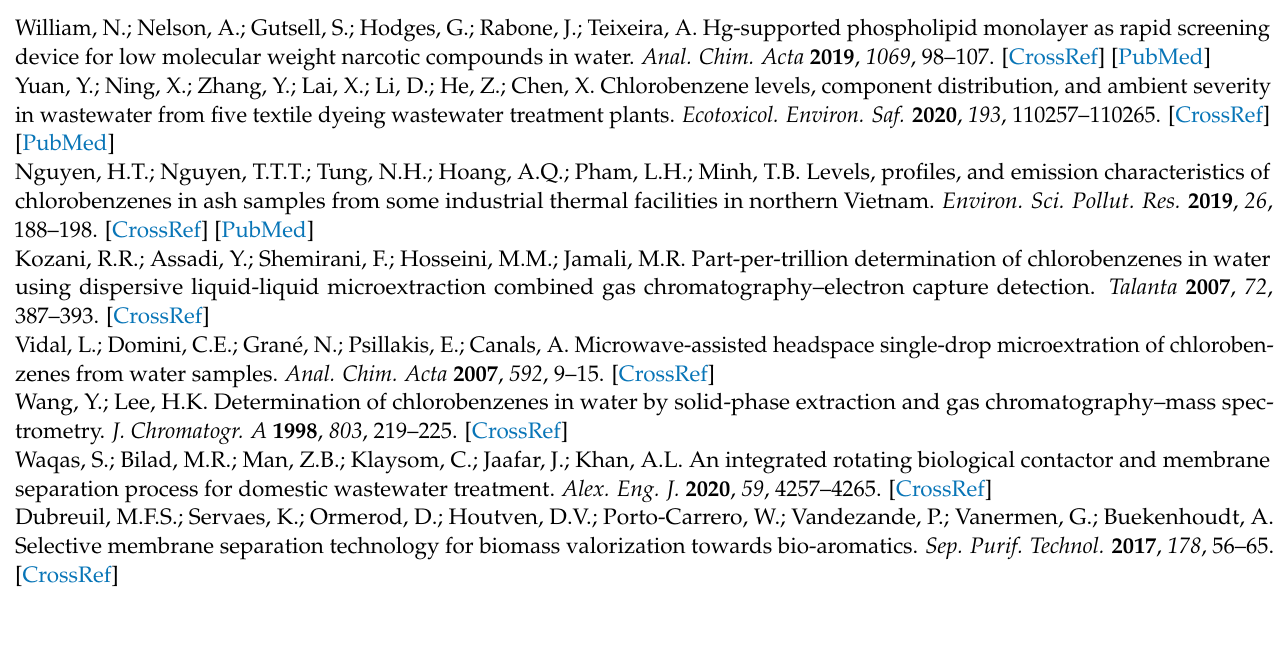
Figure S6: Effect of extraction temperature on the MMS procedure; Figure S7: Adsorption amounts of different kinds of chlorobenzene compounds by MNICM and MMICM; Figure S8: Reproducibility and stability of MNICM and MMICM. Table S1: Intra-day and Inter-day precisions and accuracies of chlorobenzene